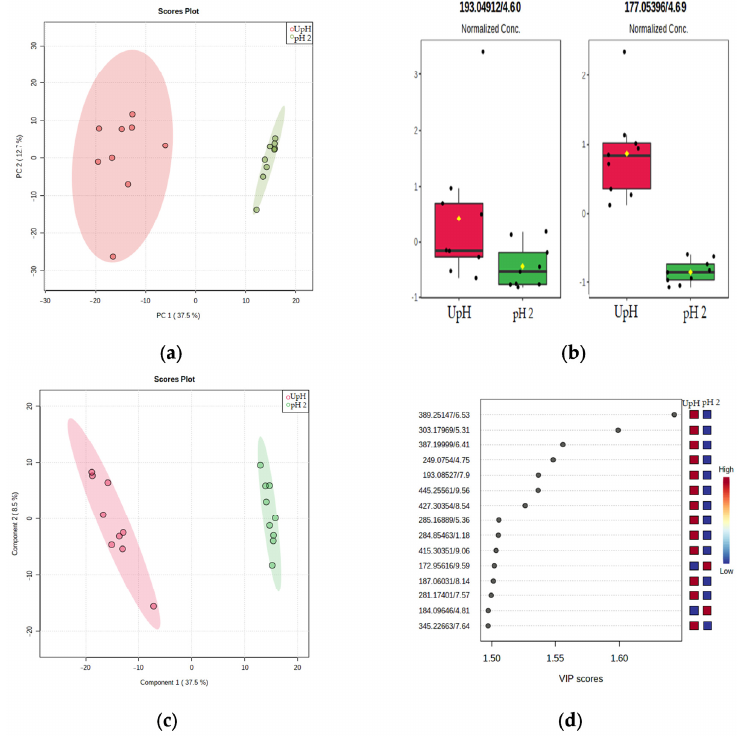
Figure 3. ( a ) PCA scores plot between PC1 and PC2. The explained variances are shown in brack- ets; ( b ) box plots reporting the normalized concentration for scytalone ( 1 ), m / z 193.0491 (4.60 min), and isosclerone ( 2 ), m / z 177.0541 (4.69 min); ( c ) PLS-DA scores plot between PC1 and PC2. The explained variances are shown in brackets. ( d ) Important features identified by PLS-DA. The colored boxes on the right indicate the relative concentrations of the corresponding metabolite in unmodi- fied pH group (UpH) and acid pH group (pH 2).